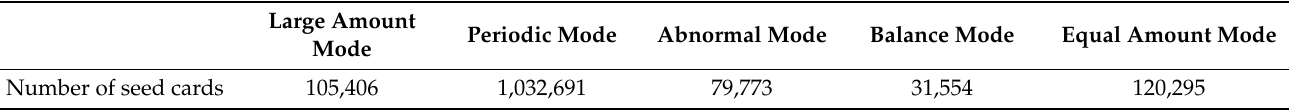
Table 4. Seed cards in typical cash-out modes.